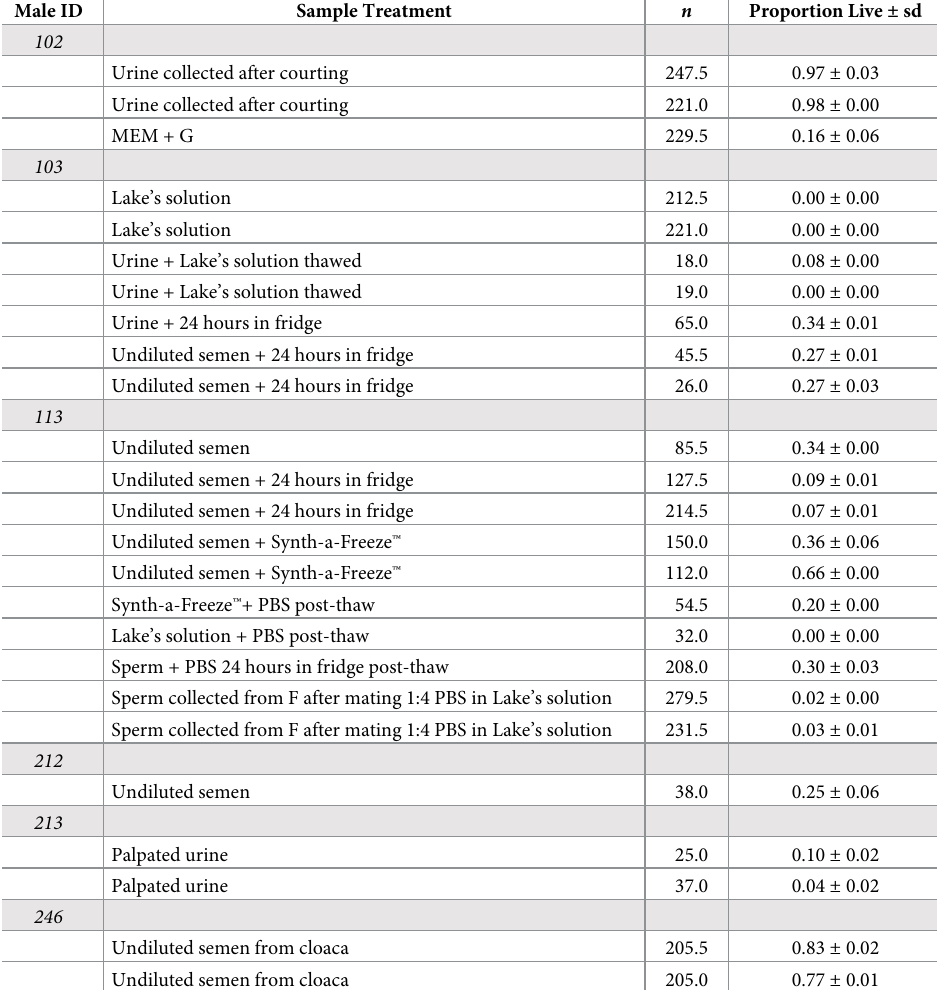
Table 2. Viability analysis results for tuatara ( Sphenodon punctatus)